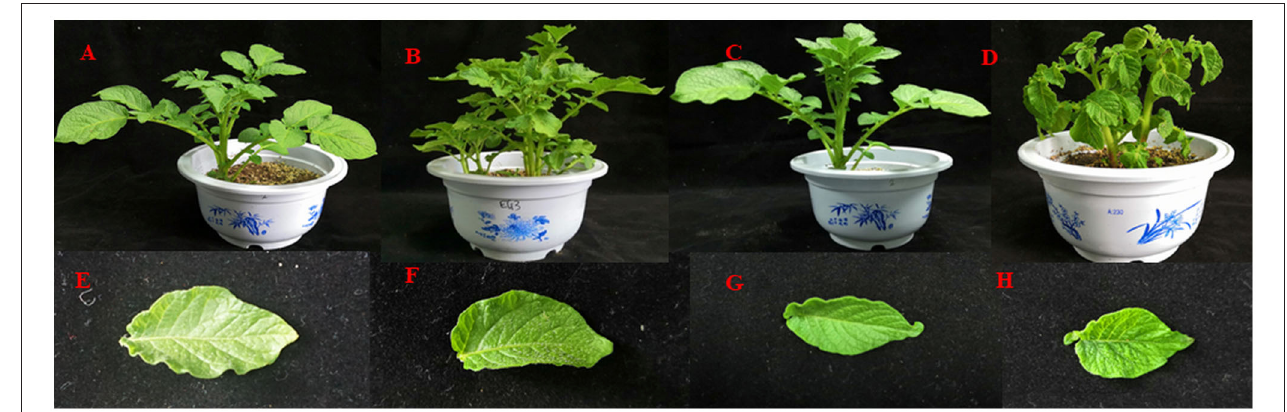
FIGURE 1 | Morphological changes of leaves from potato treated during low-temperature stress. (A,E) The control group in which the plants were grown at 20 ◦ C for 4h (S01); (B,F) The treatment groups in which plants were grown at chilling temperature (0 ◦ C, S02). (C,G) The treatment groups in which plants were grown at critical growth temperature (2 ◦ C, S04); (D,H) The treatment groups in which plants were grown at water freezing temperature ( − 2 ◦ C, S05).